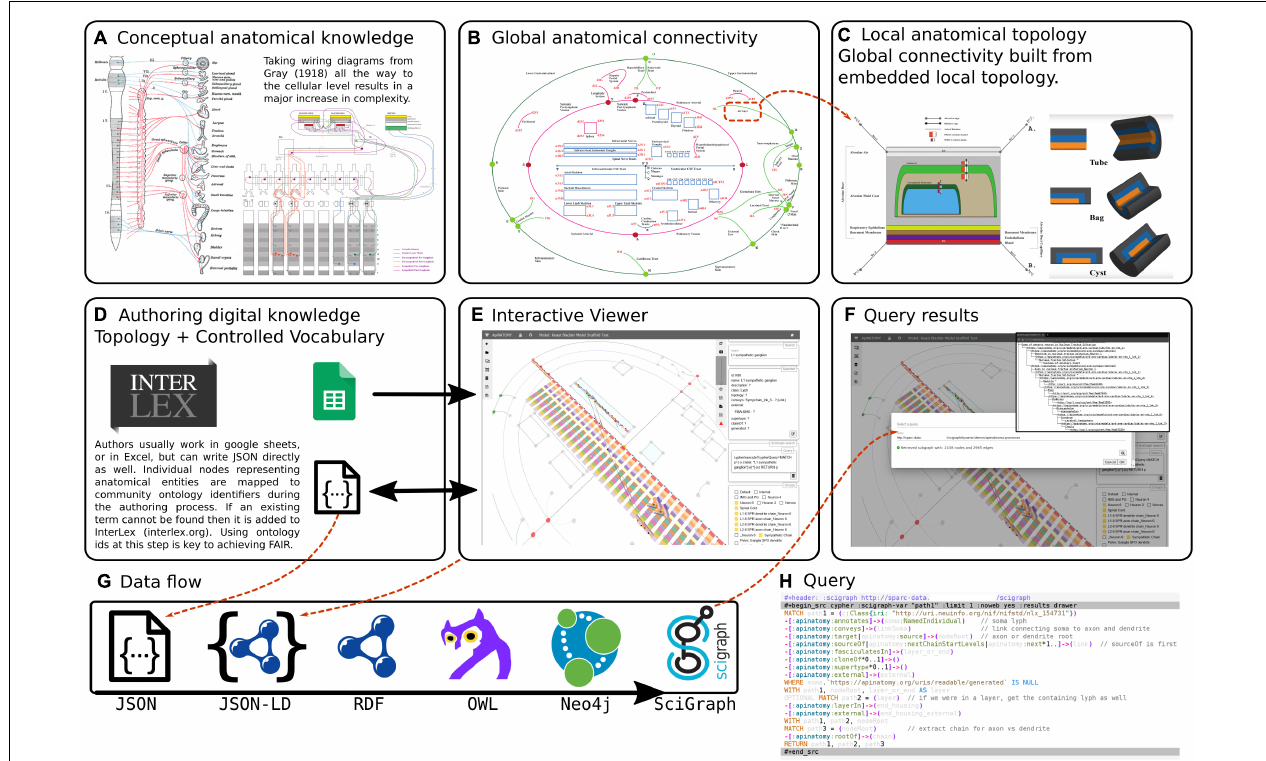
FIGURE 2(i) | An overview of the ApiNATOMY infrastructure. The top row of three panels illustrates the transition from conceptual to formal representation of physiology knowledge. (A) An example of a traditional connectivity wiring diagram. (B) Display of TOO Map global scaffold. (C) An example of conduit representation in ApiNATOMY. The second row of three panels explains the technical model transformation pipeline. (D) The ApiNATOMY authoring process. (E) The visualization of an ApiNATOMY model in the graphical viewer after its conversion to the expanded JSON format. (F) The results of competency query execution from the visual editor. (G) The JSON-to-SciGraph conversion steps. (H) Key components of the ApiNATOMY architecture